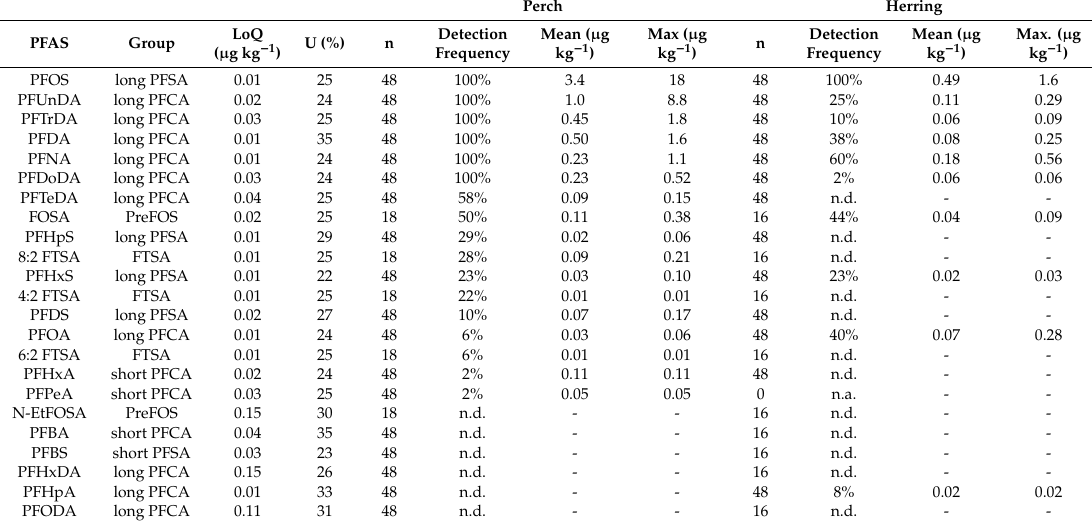
Table 5. Summary of analysed PFASs in perch and herrings. Concentrations are presented per fresh weight (f.w.).